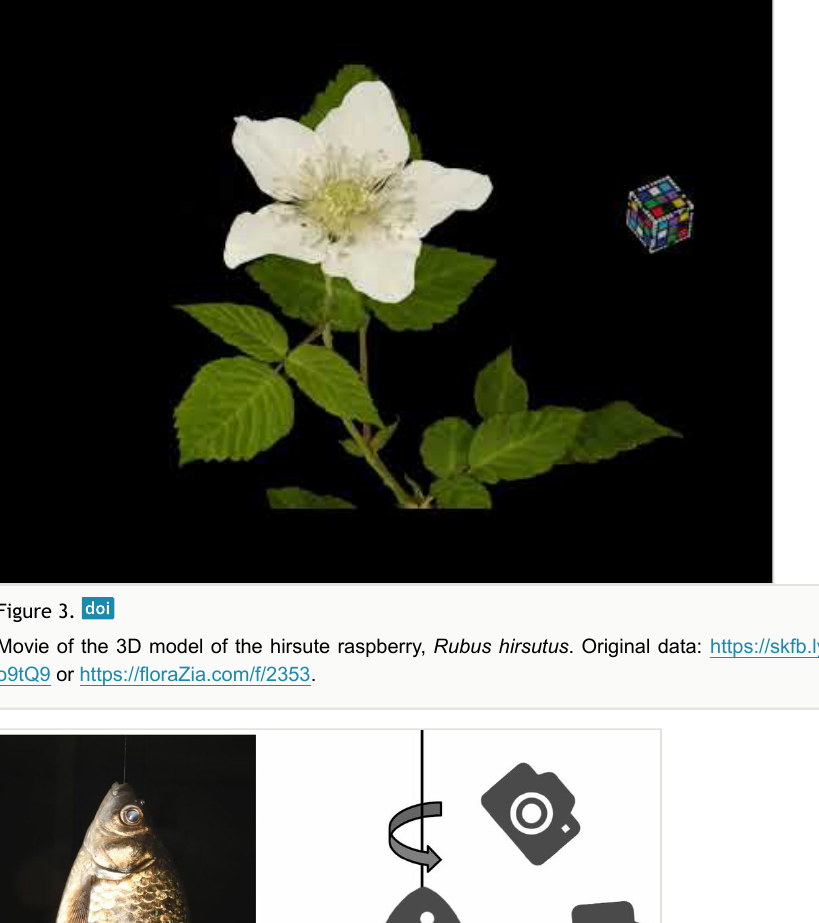
Movie of the 3D model of the hirsute raspberry, Rubus hirsutus . Original data: https://skfb.ly/ o9tQ9 or https://floraZia.com/f/2353.